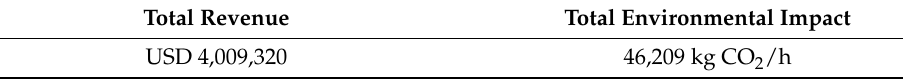
Table 15. Economic potential and environment impact in scenario